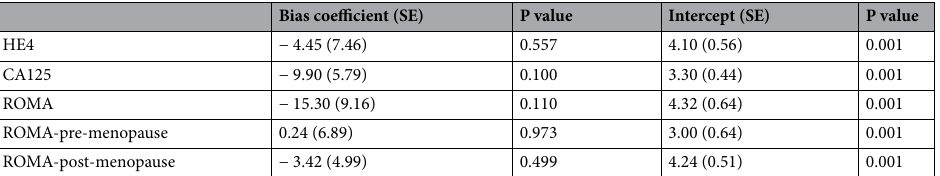
Table 4. Statistical tests for publication bias by regression analysis of ln(DOR) against inverse of square root of effective sample size. Human epididymis secretory protein 4 (HE4), Cancer antigen (CA125) and Risk of Ovarian Malignancy Algorithm (ROMA). Standard error